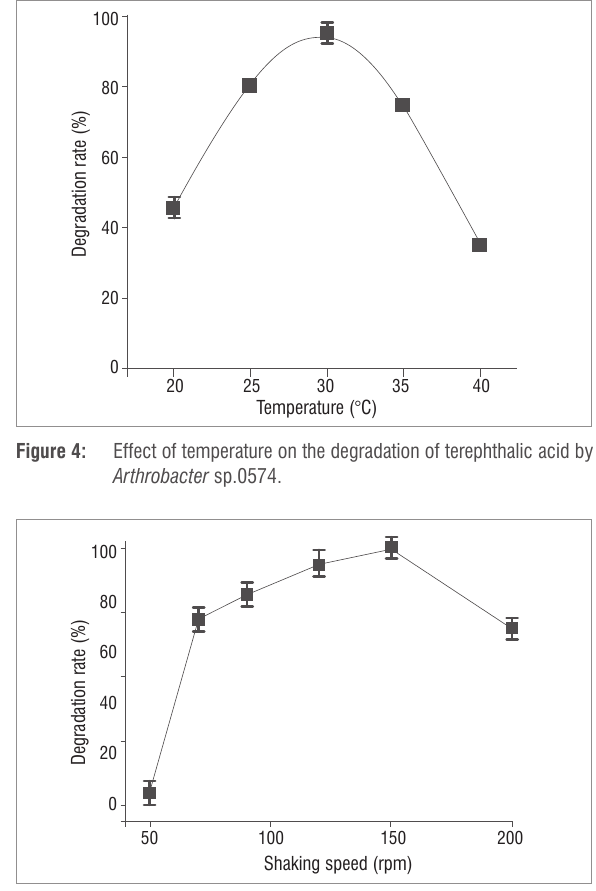
South African Journal of Science http://www.sajs.co.za